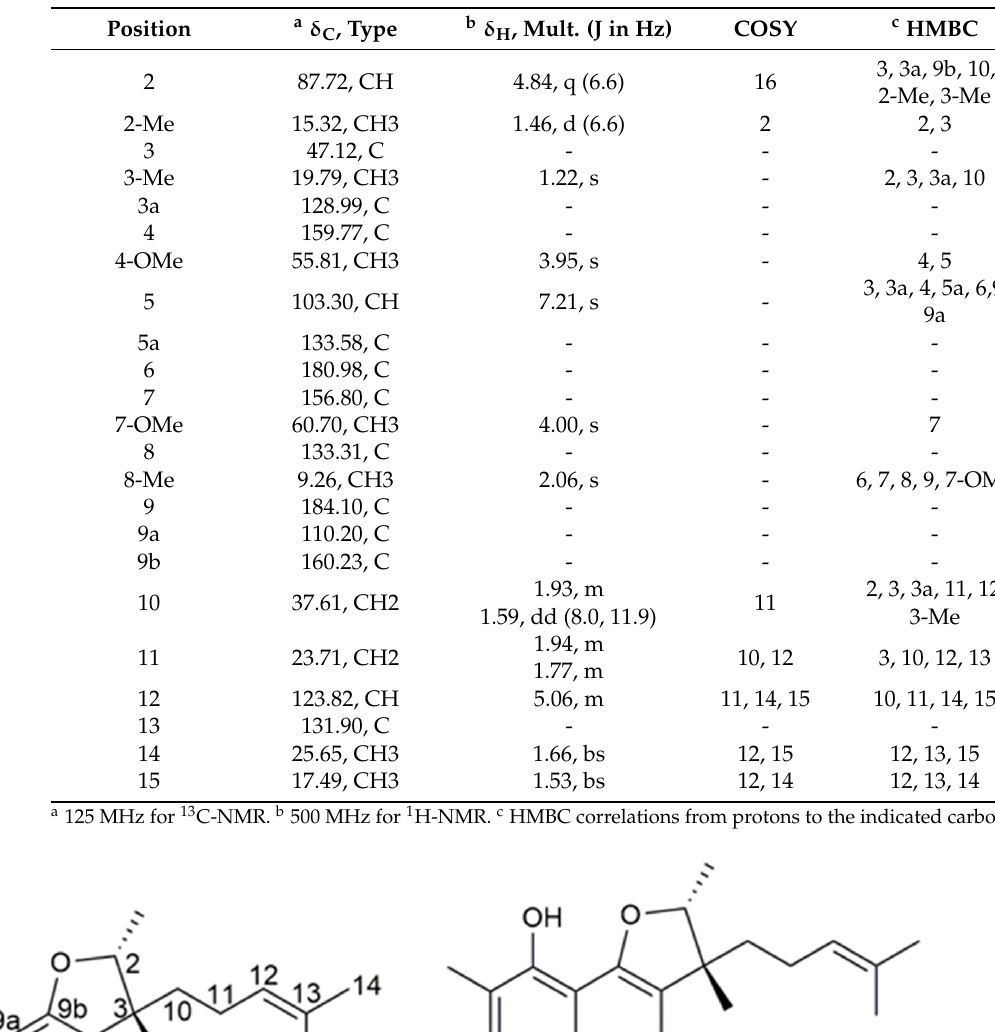
Table 1. NMR chemical shifts and 2D correlations of furaquinocin K recorded in CDCl 3 .